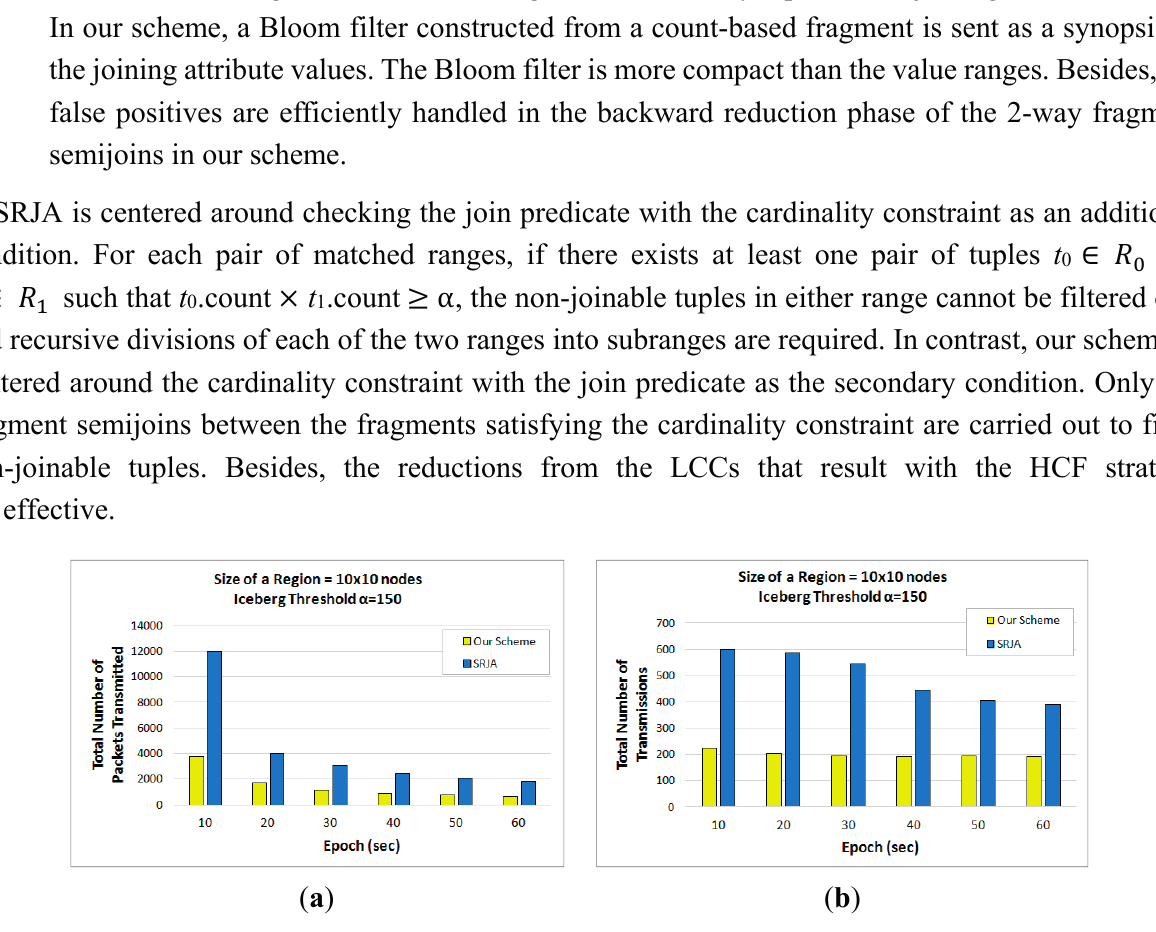
Figure 13. Performance Comparison with respect to Varying Epochs. (10 × 10 nodes, α = 150 ). ( a ) Total number of packets transmitted; ( b ) Total number of transmissions.